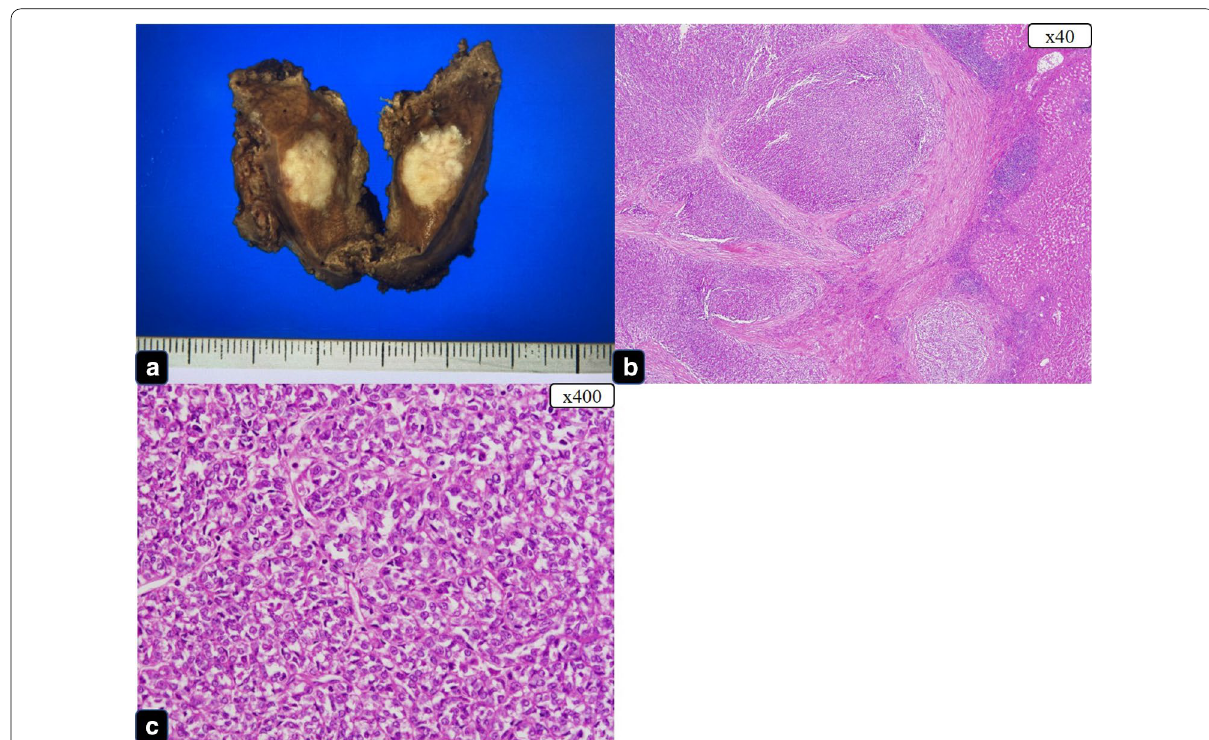
Fig. 7 The single metastatic tumor was located in the liver. a Resected specimen (liver) and cut surface, white solid tumor with clear boundary. b HE stain, low-power view. c HE stain, high-power view